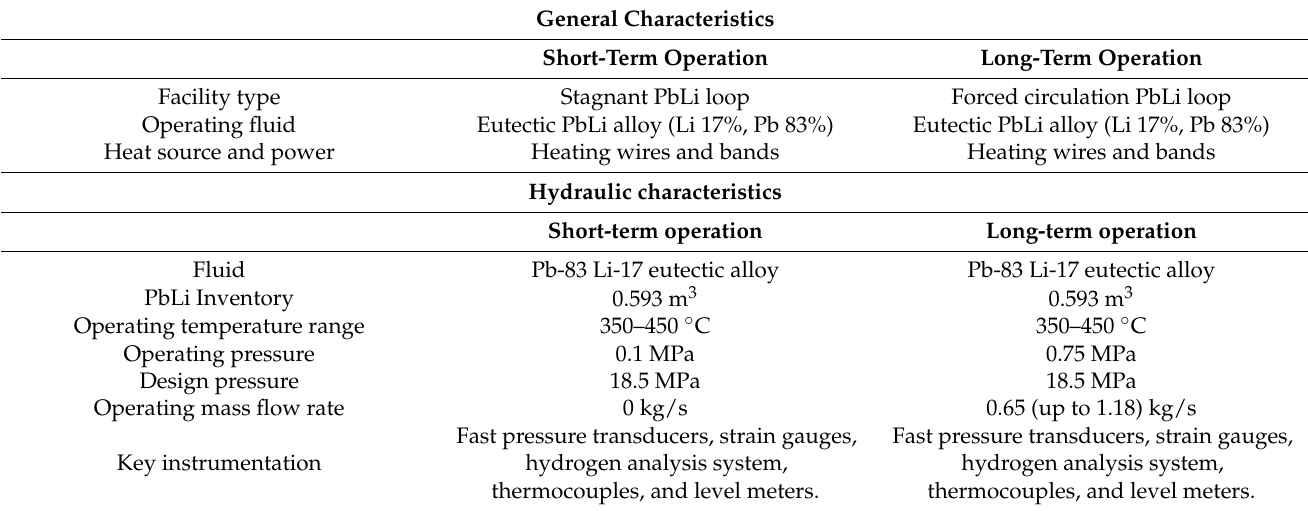
Table 1. LIFUS4/Mod4 Operational